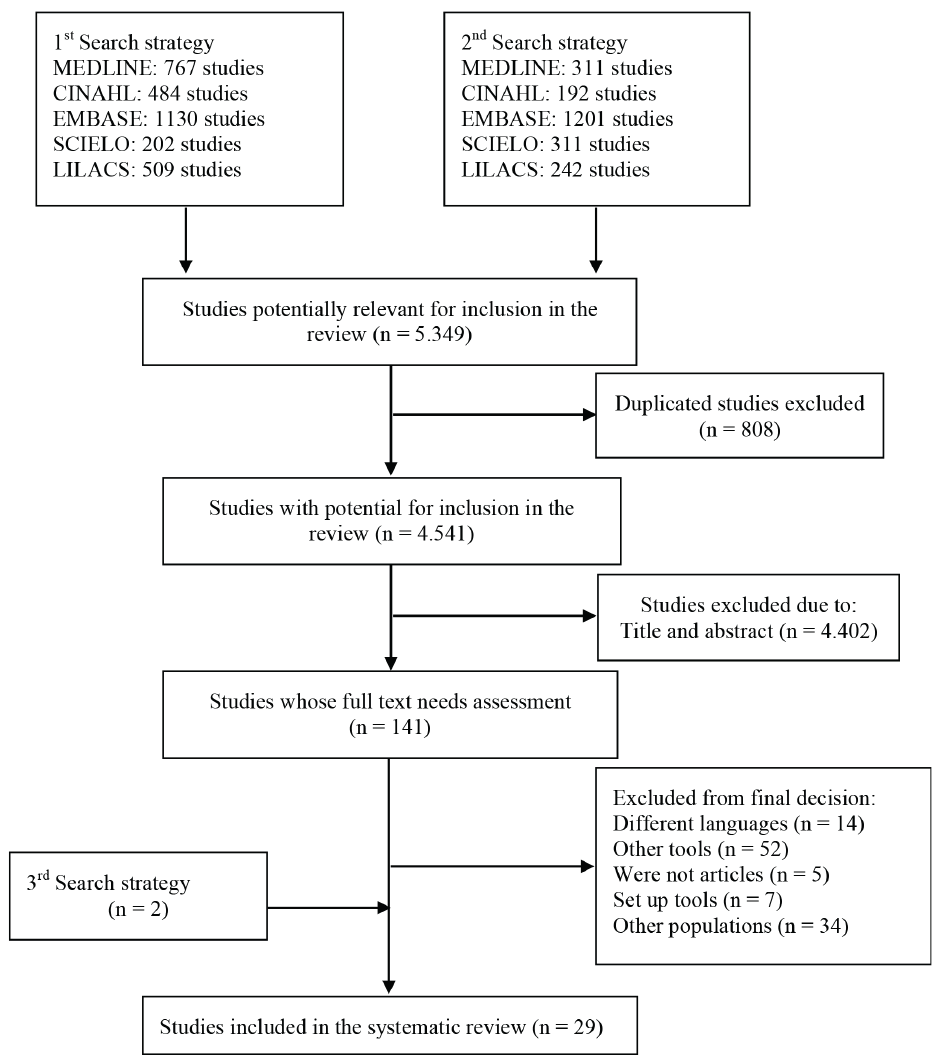
Figure 1 - Flowchart of Systematic